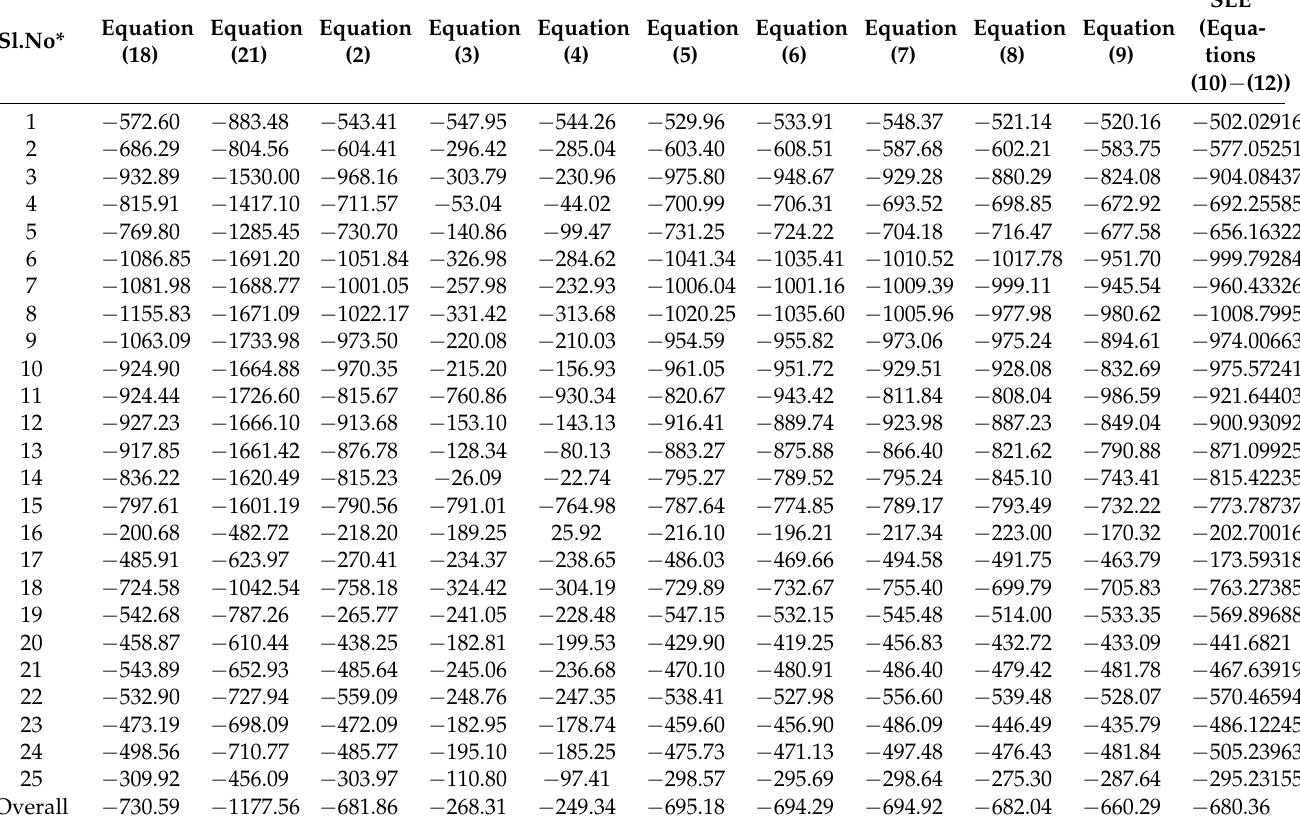
Table 8. AIC information of the proposed models and literature